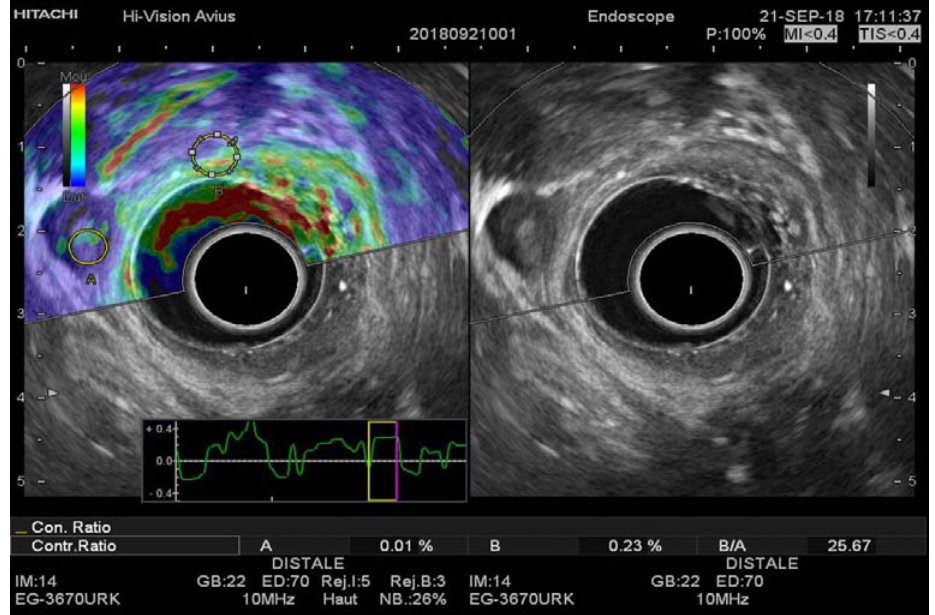
Figure 4. Images of a 60-year-old man with pT2N1 rectal cancer. Regions of interest for the EUS-RTE measurements were placed on a suspicious lymph node ( A ) and the normal portion of the rectal wall ( B ), superimposed on the B-mode image. RTE, real-time elastography.